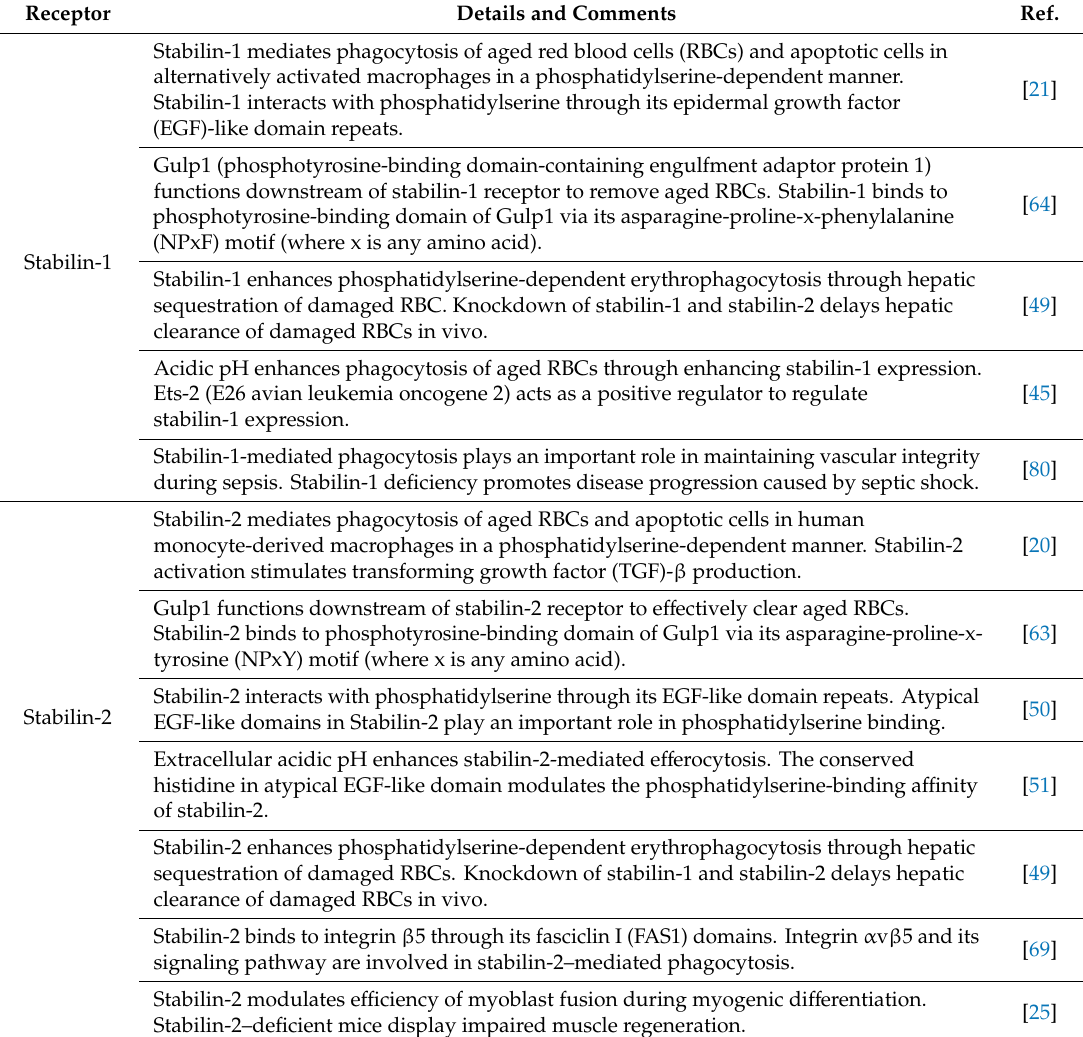
Table 1. The roles of stabilin-1 and stabilin-2 as phosphatidylserine receptors. Receptor Details and